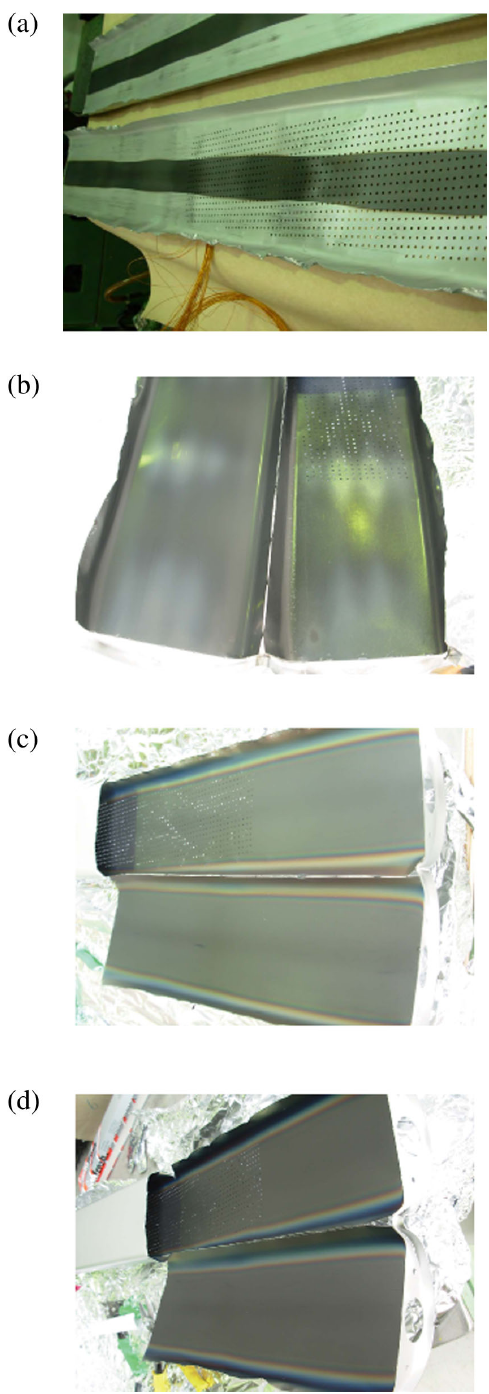
FIG. 12. The comparison of the pressure measurements of the uncoated and coated dipoles. The nominal LHC beam which consisted of one, two, three, and four batches with 72 bunches at 25 ns spacing and intensity of 10 11 protons = bunch .